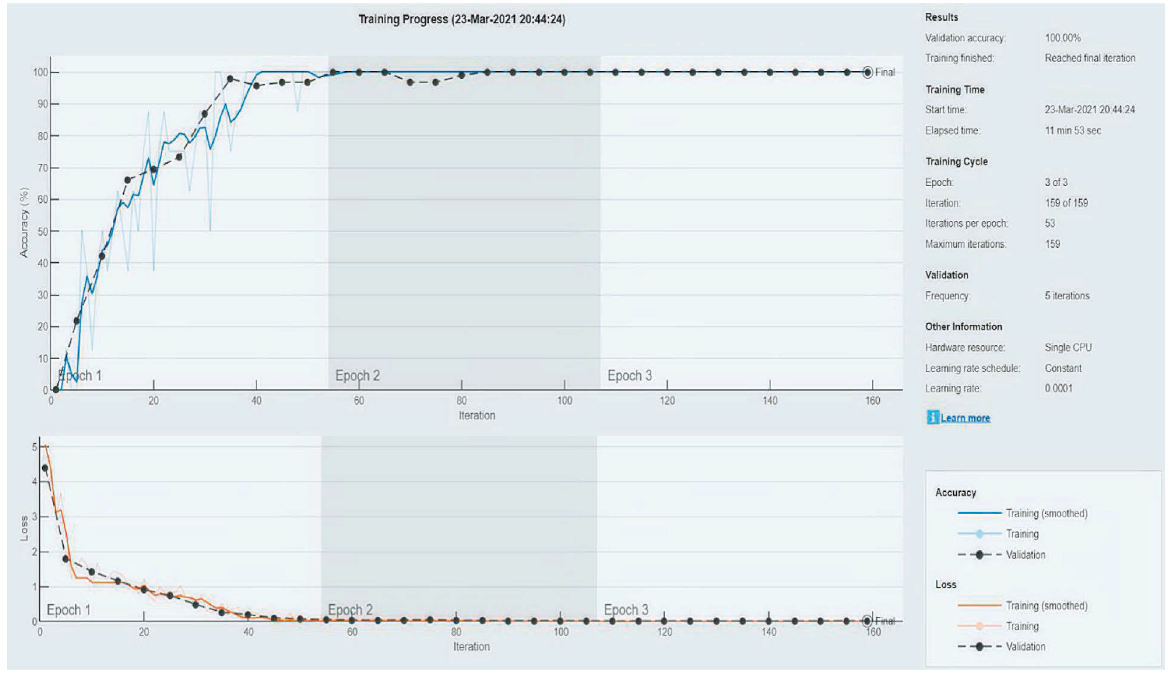
Figure 19: Training progress of SqueezeNet for fault classification of thermal images of solar panels. Table 7: Intermediate results of thermal images trained in